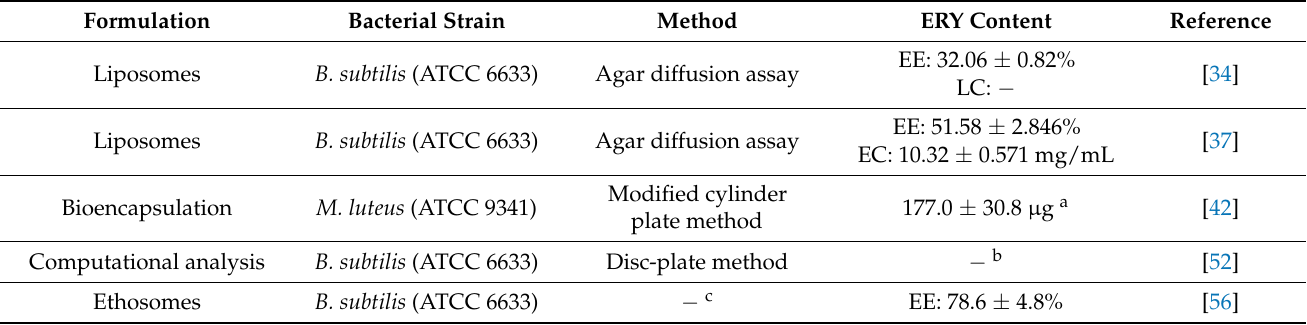
Table 4. ERY quantification procedures by microbiological methods in the